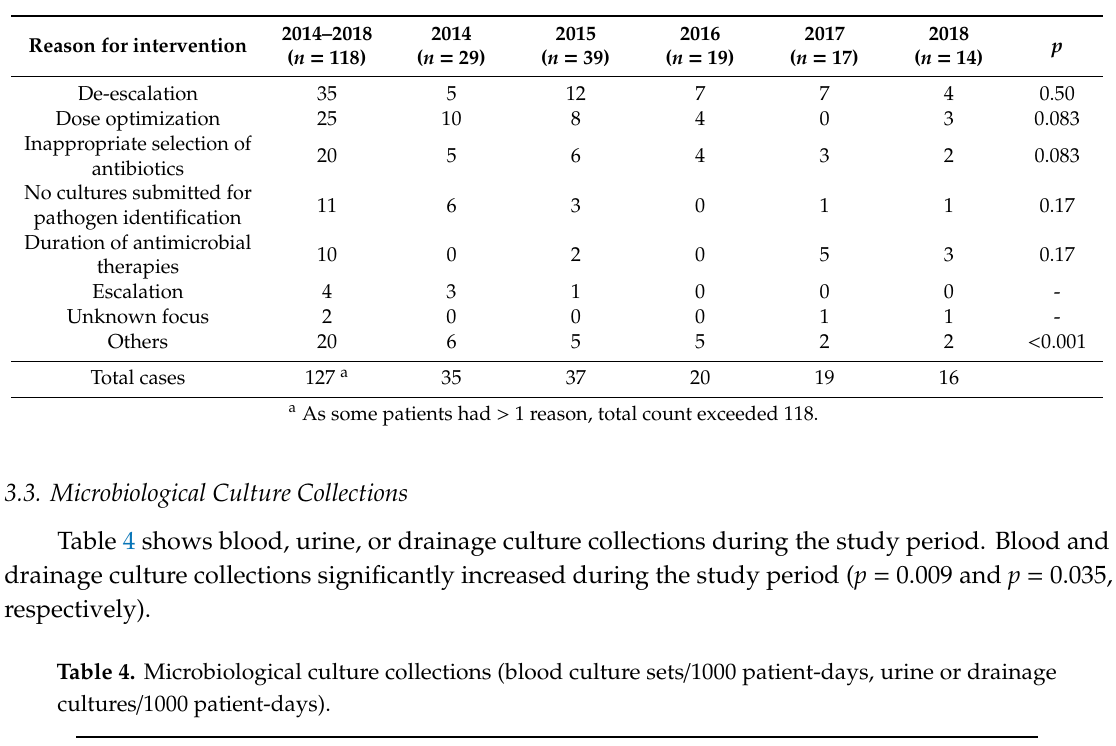
Table 3. Reasons for AST intervention.